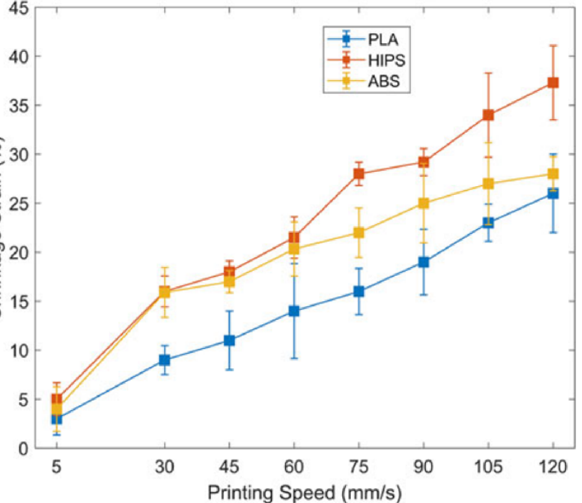
Figure 1. Effect of printing speed on the shrinkage strain [48]. Material from: Rajkumar, A.R.; Shan- mugam, K, Additive manufacturing-enabled shape transformations via FFF 4D printing, published (2018) (Springer Nature) reproduced with permission of